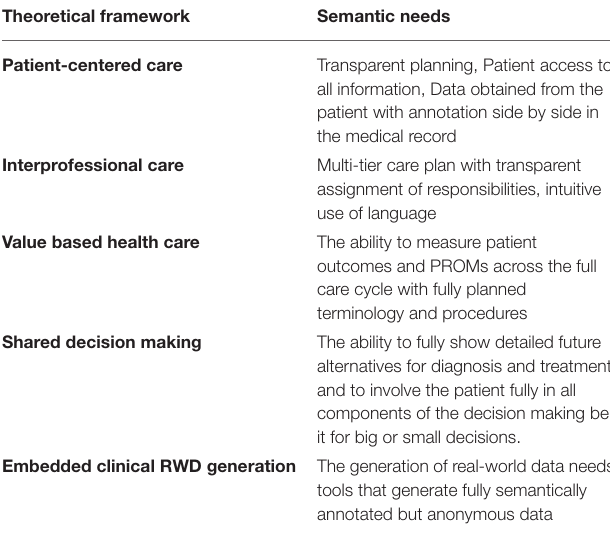
TABLE 1 | The different concepts from modern health care development that have been targeted to be met with the methodology presented in this paper. Their respective impact on informatics was determined by the authors for later inclusion in the construction of the present framework. References: Person-Centered Care (19), Interprofessional care (20), Value based healthcare (21). Shared decision making (2), Embedded trials (22).